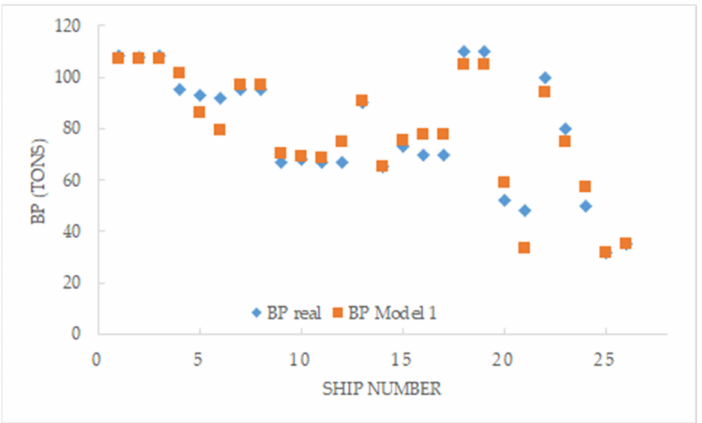
Figure 1. Representation of tugs’ BP obtained with Model 1.